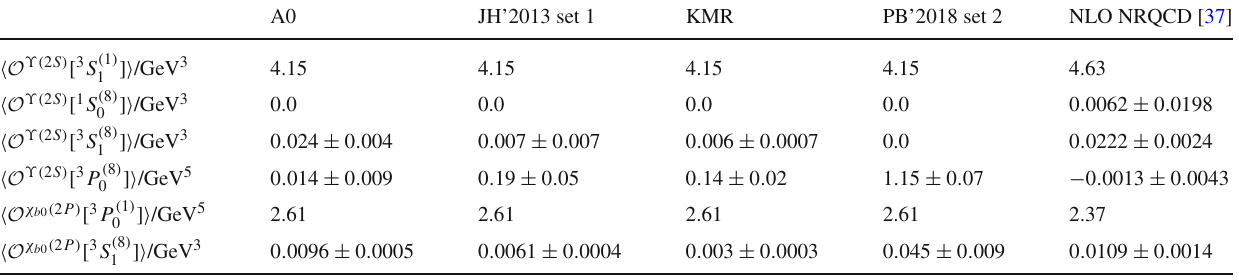
= 10 GeV. The NMEs obtained in the NLO NRQCD [37] T